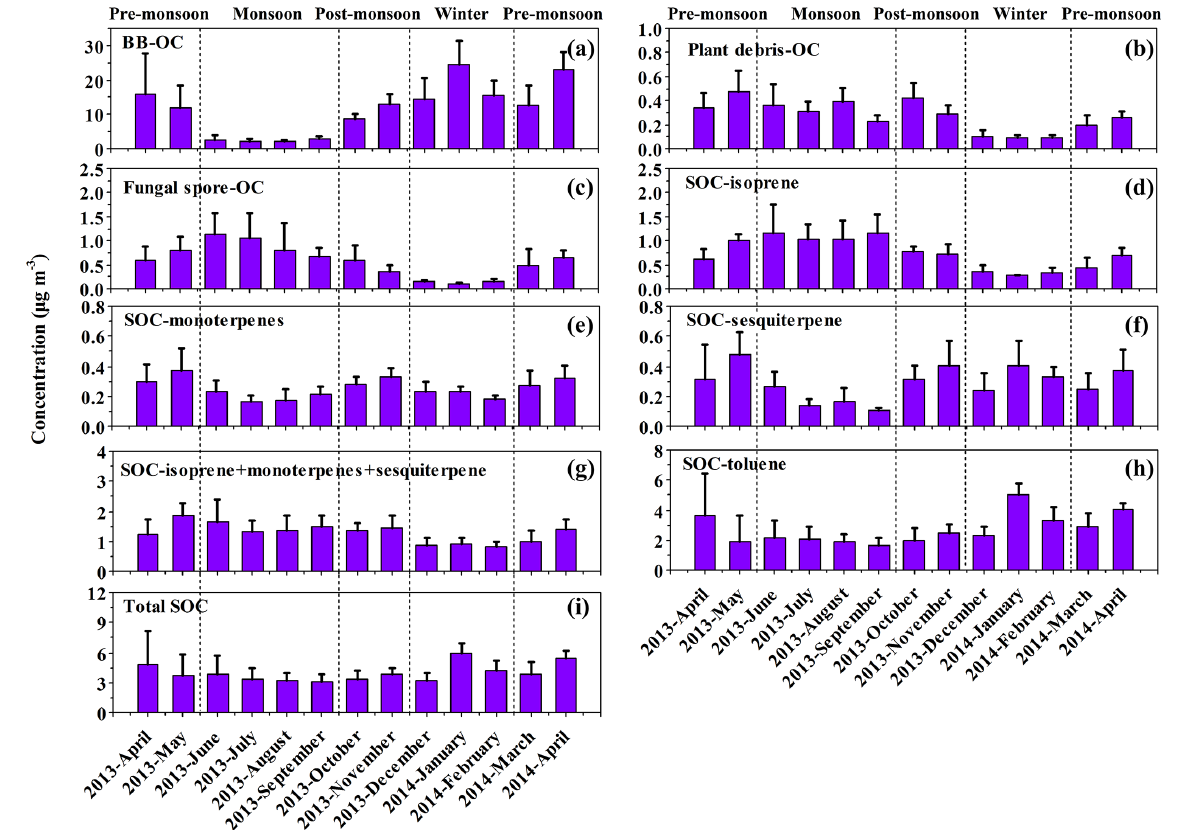
Figure 10. Monthly concentration variations in (a) BB-OC, (b) plant-debris-OC, (c) fungal-spore-OC, (d) SOC-isoprene (I-SOC), (e) SOC- monoterpenes (M-SOC), (f) SOC-sesquiterpene (SOC-C), (g) SOC-isoprene + monoterpenes + sesquiterpene (B-SOC), (h) SOC-toluene (A-SOC), and (i) total SOC that were estimated using a tracer-based method at the Bode site, Kathmandu Valley, during April 2013– April